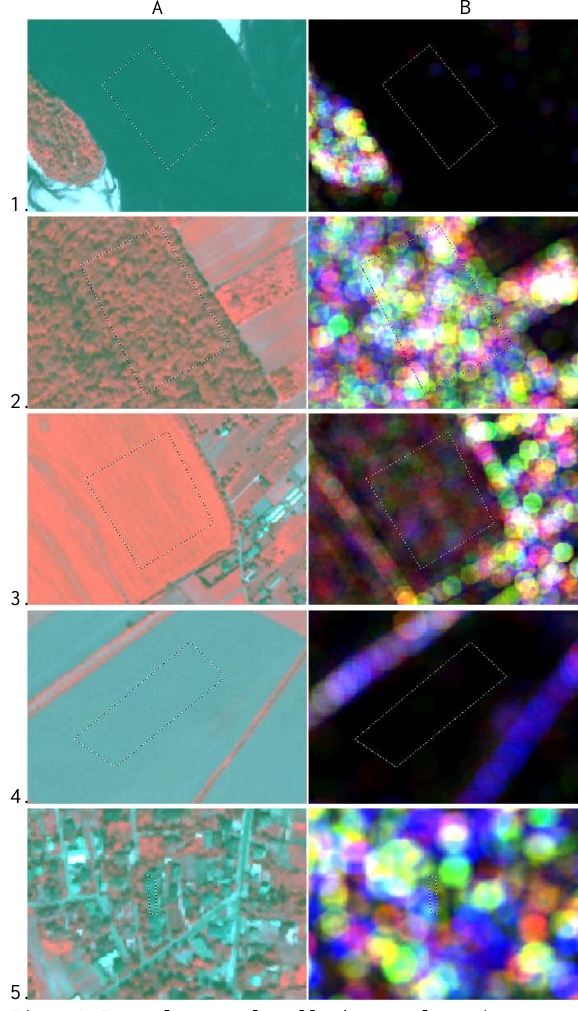
Figure 2. Exemplary samples of land cover classes in a spectral colour composition and in a colour composition consisting of granulometric maps: water (1), forest (2), low vegetation (3), bare soil (4), built-up area (5).